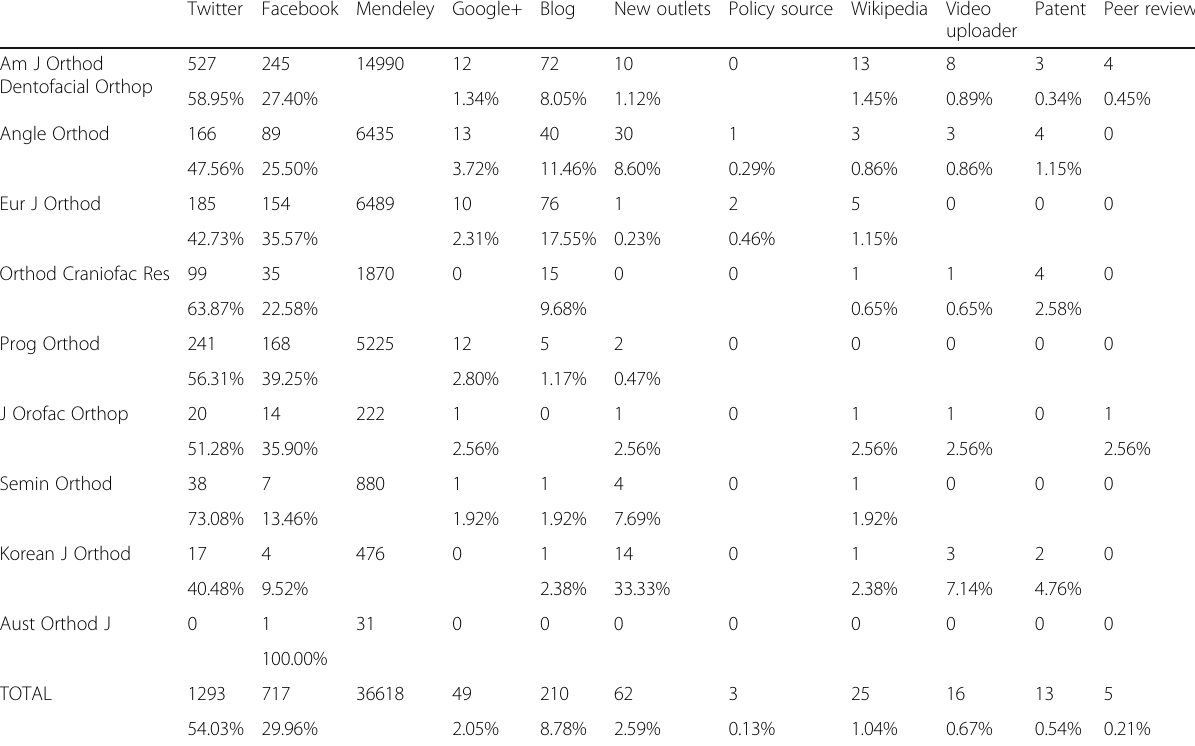
Table 2 Breakdown of different Altmetric data resources of the selected journals from 2014 to 2017, and the normalized contribution of each resource is expressed in